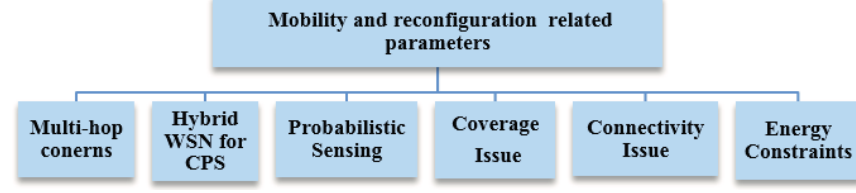
Figure 5. Wireless sensor network parameters and issues related to mobility and reconfiguration in a cyber-physical